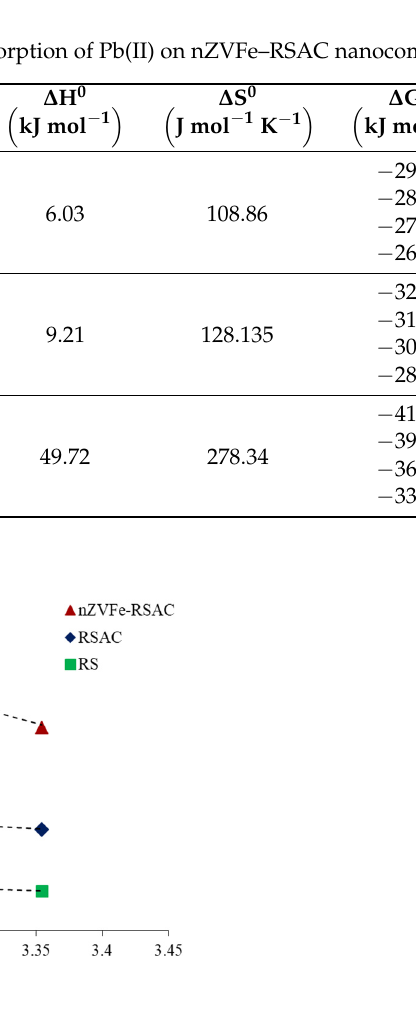
Figure 12. Temperature effect on sorption coefficients (k d ) for Pb(II) adsorption by RS, RSAC, and nZVFe–RSAC